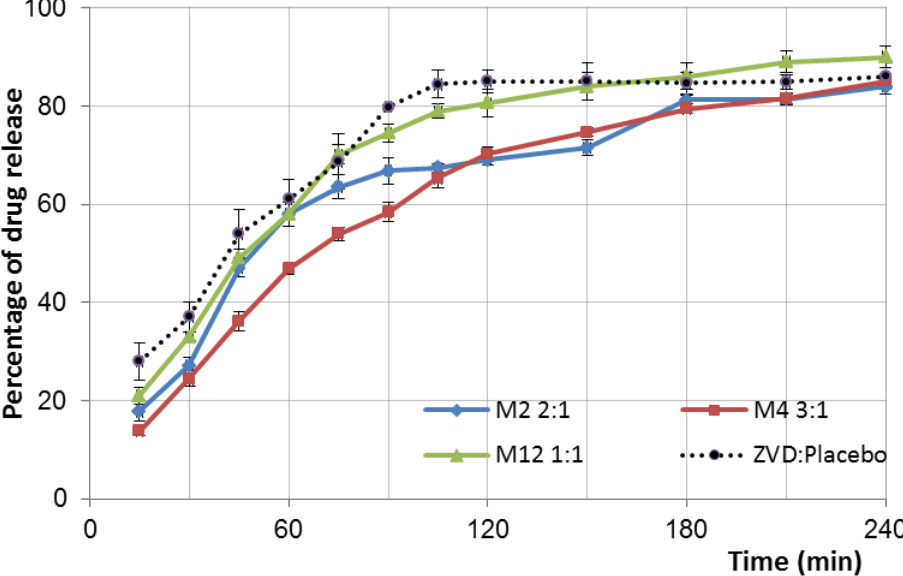
Figure 2. In vitro Zidovudine (ZVD) release from microparticles M2, M4, and M12 differed in chitosan glutamate (gCS):CF ratios compared to the ZVD blend with placebo microparticles (gCS:CF 2:1, w/w ), displaying the impact of the ion crosslinker (CF) ratio on the dissolution profile (mean ± SD; n = 3).